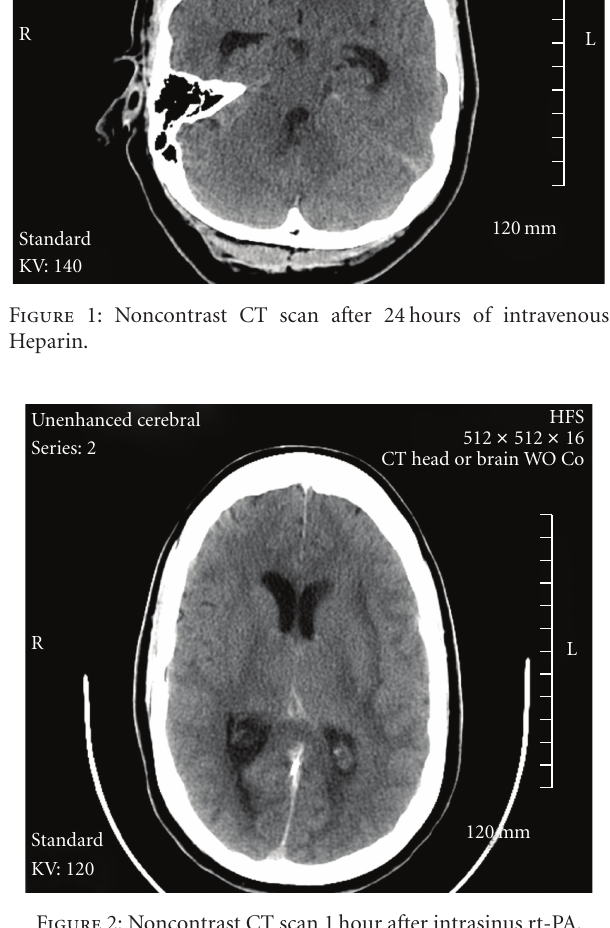
Figure 2: Noncontrast CT scan 1hour after intrasinus rt-PA.